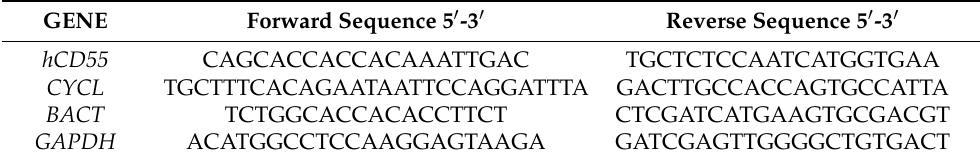
Table 1. Primers used in RT-PCR 1